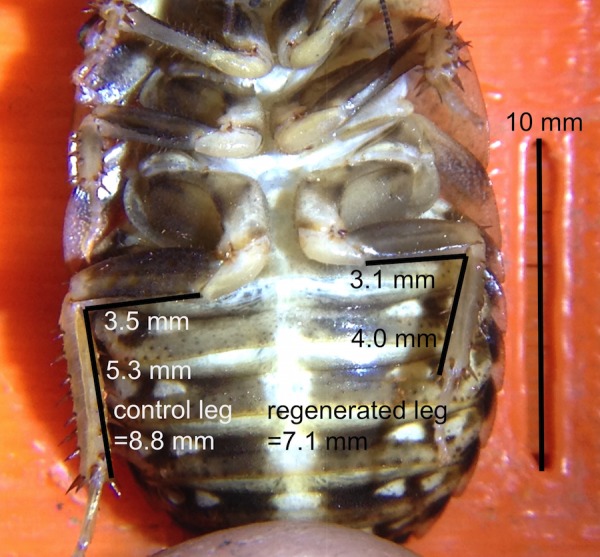
Cockroach Leg Measurement.Example of measurement of cockroach leg photographs using 10 mm reference guides on microscope base and the NIH ImageJ analysis program.